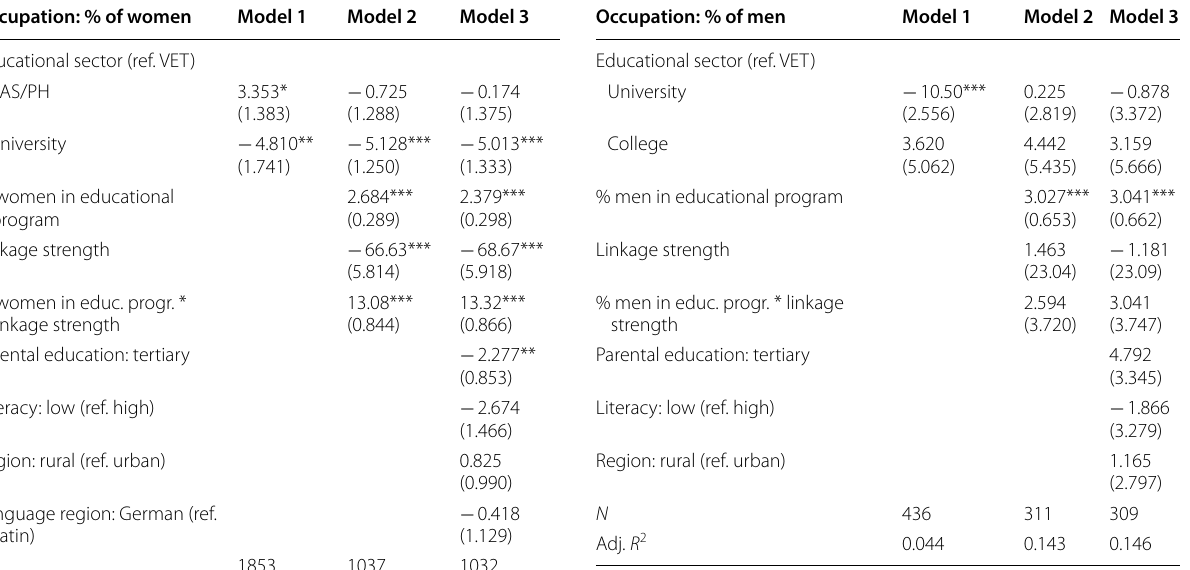
Table 7 Influence of educational gender concentration and linkage strength on